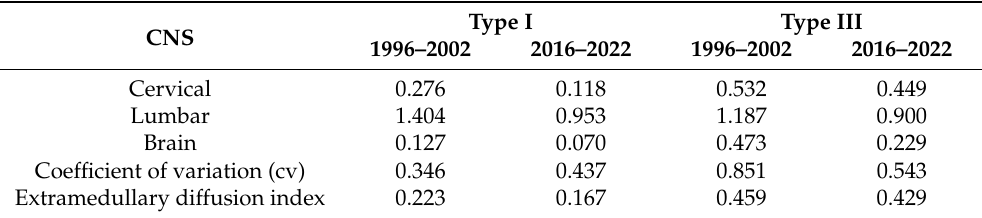
Figure 3. Statistical of pathological lesion tissue of type I and type III. *** p < 0.01 compared with type I group. Table 3. Statistics of the average lesion scores in different central nervous systems from 1996 – 2002 and 2016 – 2022.